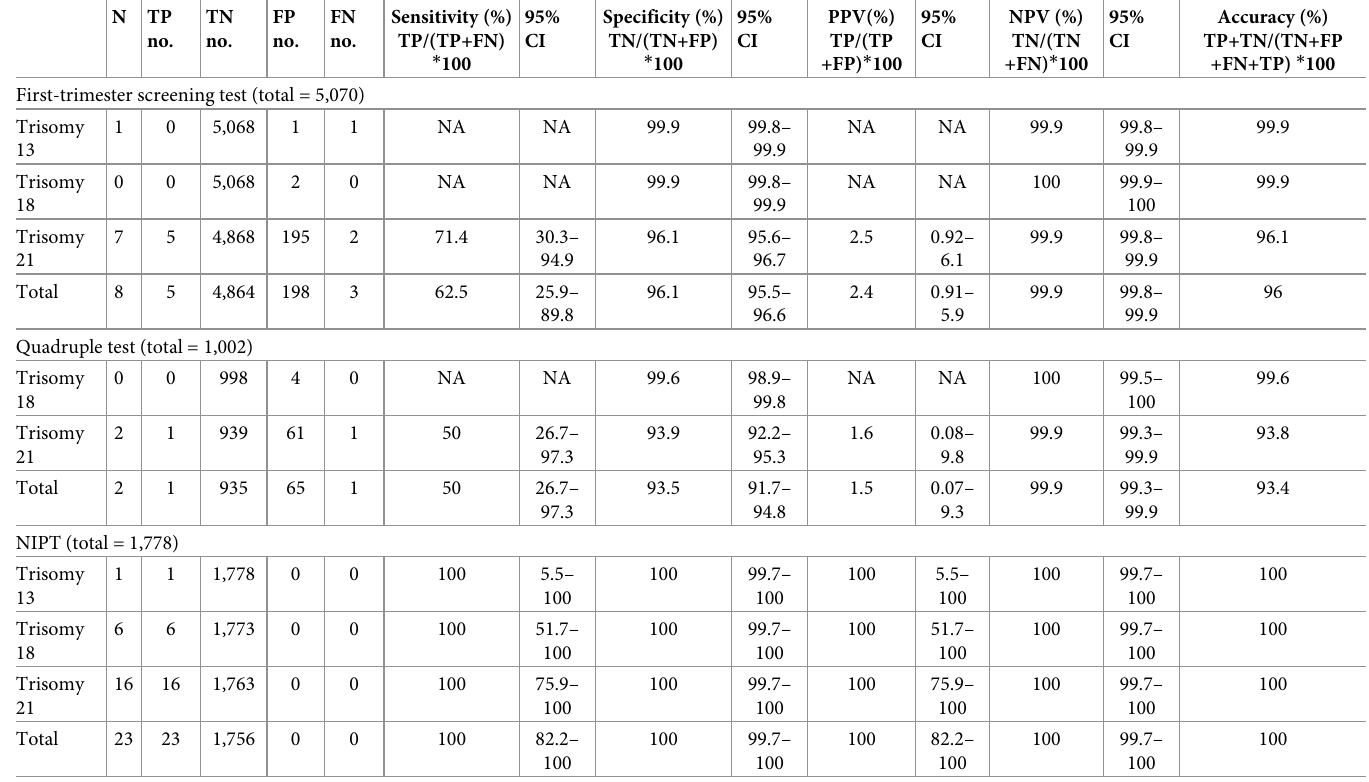
Table 1. Performance of prenatal screening test.